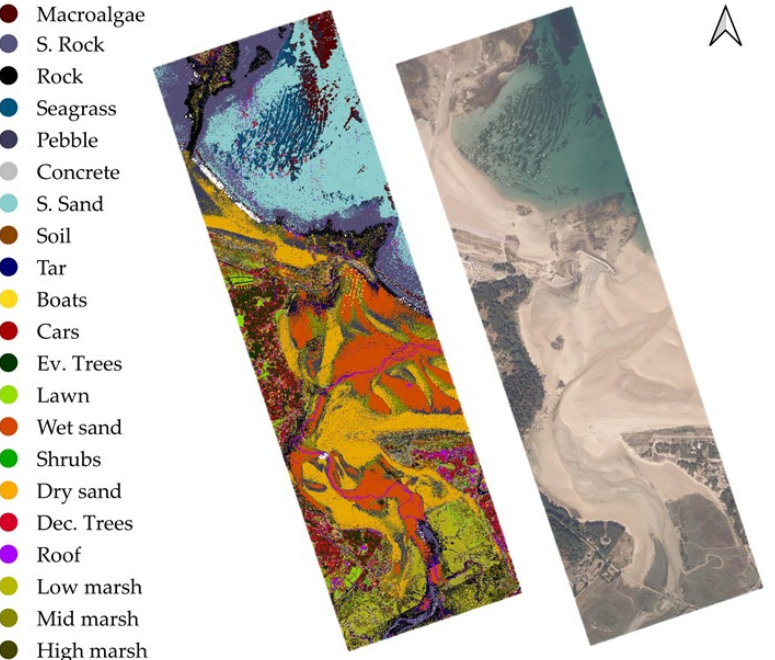
Figure A2. Projected 3D map of the habitats obtained with the predictions of a random forest classifier on green spectral features and infrared intensities; orthoimage of the study area. The orthoimage was captured in 2014, while lidar data are not contemporaneous as they date from 2019. S. = submerged, Ev. = evergreen, Dec. = deciduous.